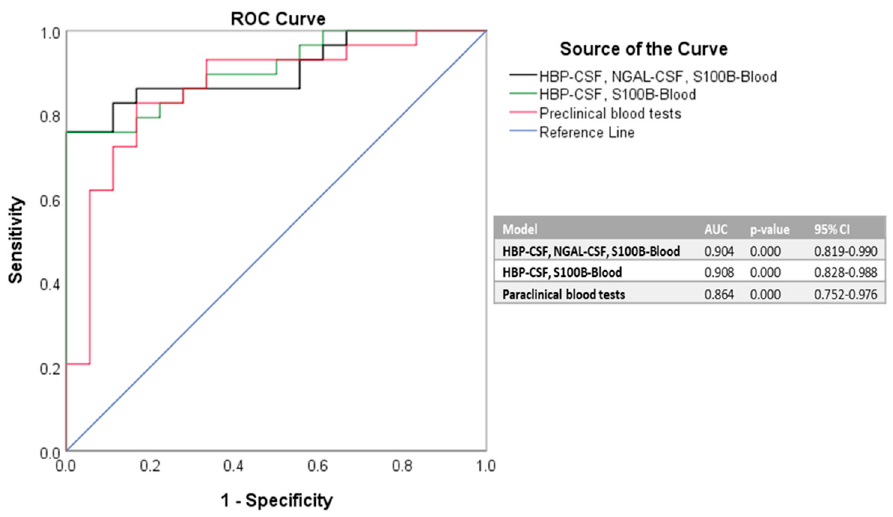
Figure 1. ROC curves for various associations of biomarkers. Model 1 comprises the values of HBP and NGAL in CSF and S100B in blood, model 2 comprises the values of HBP in CSF and S100B in blood, while model 3 relies on the significant biomarkers identified during the paraclinical blood tests (WBC, PMN, Ly, CRP, ESR, Fib, creatinine). The AUC values > 0.9 define an outstanding discrimination, while the AUC values between 0.8 and 0.9 denote an excellent capacity for the prediction models [24].